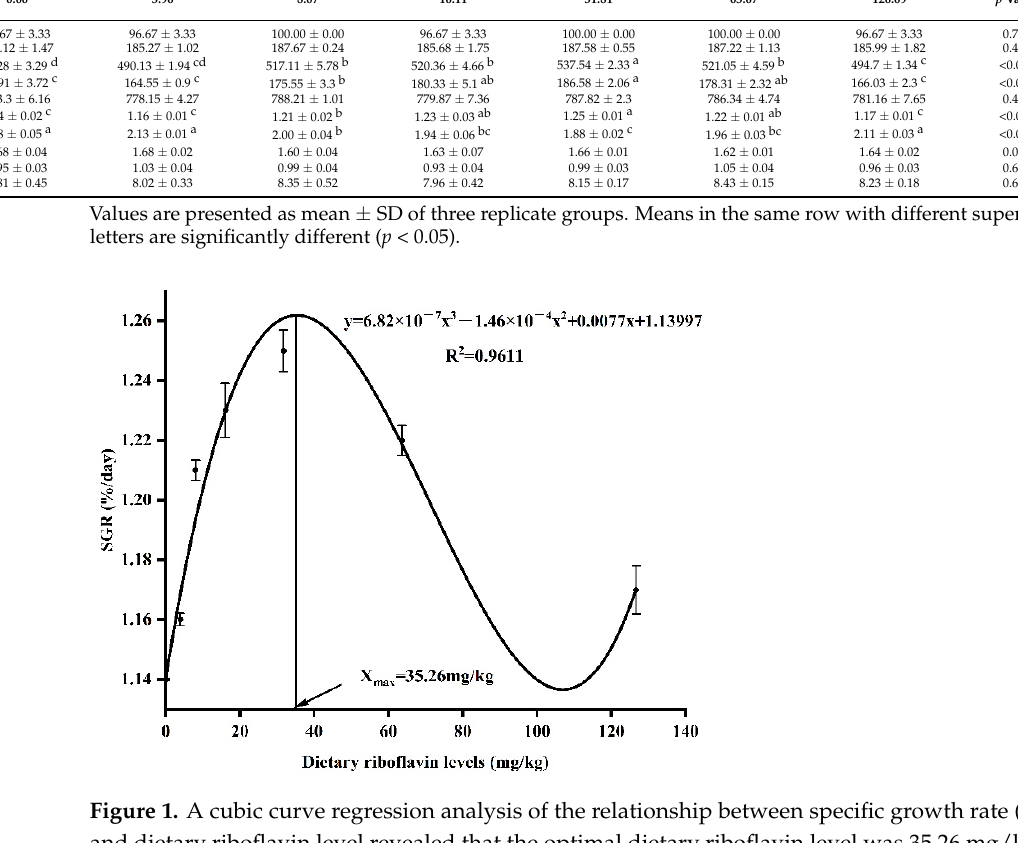
Table 2. Effects of graded dietary riboflavin levels on survival, growth performance and feed utilization of coho salmon ( Oncorhynchus kisutch ) post-smolts for 12 weeks. DietaryRiboflavinLevels (mg/kg)